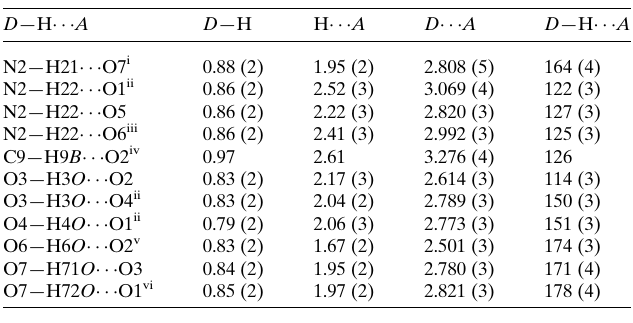
Table 11 Hydrogen-bond geometry (A˚ , (cid:5) ) for 12 .